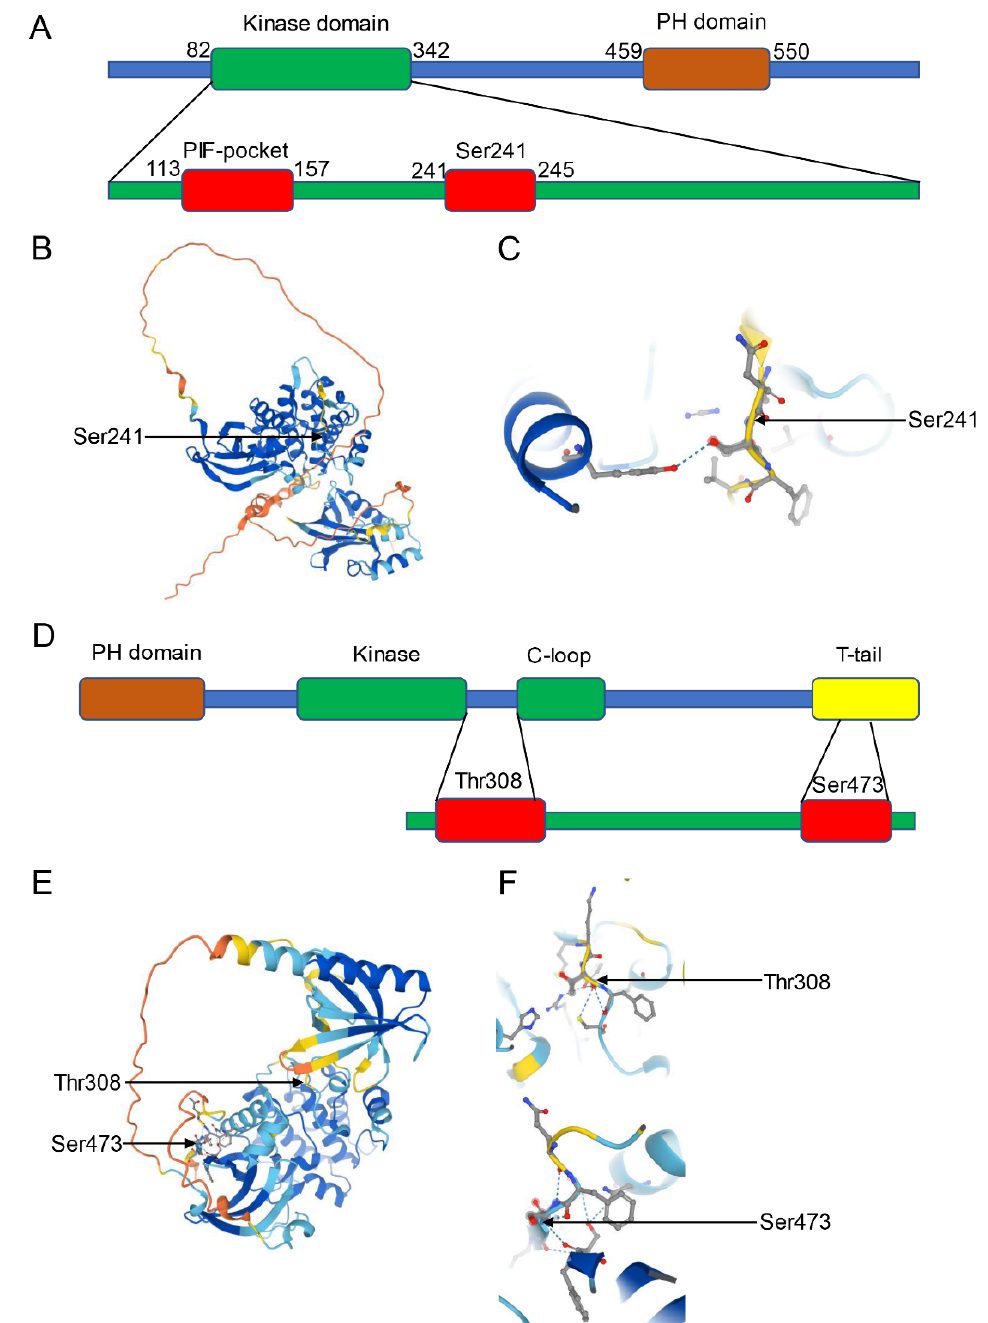
Figure 3. ( A ) The general structure of the peptide chain of PDK1. ( B ) Structural features of the catalytic core of PDK1. Ser241 represents the phosphorylation site inside the activation loop. ( C ) Structural features of the Ser241 of PDK1. ( D ) The general structure of the peptide chain of Akt. ( E ) Structural features of the catalytic core of Akt. Ser473 in the regulating domain and Thr308 in the catalytic domain of the activation loop represent the phosphorylation site. ( F ) Structural features of the Ser473 and Thr308 of Akt.